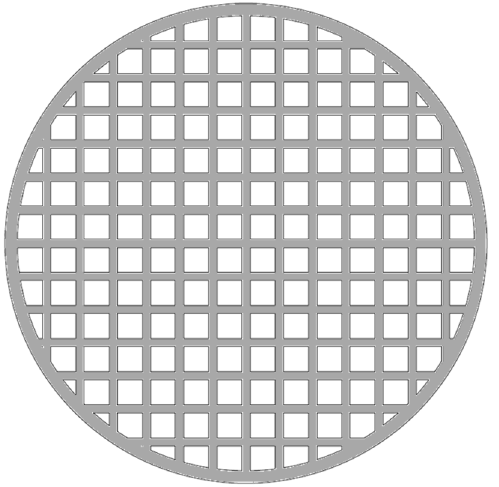
Figure 5. Cross-section of a substrate with square channels.